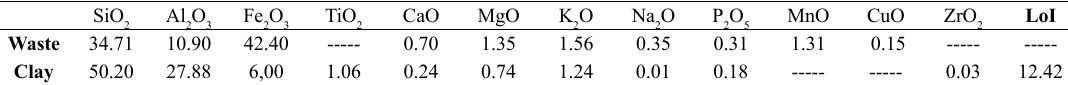
Table 1. Chemical composition (%) of the ceramic clay and Sulfatreat waste. SiO 2